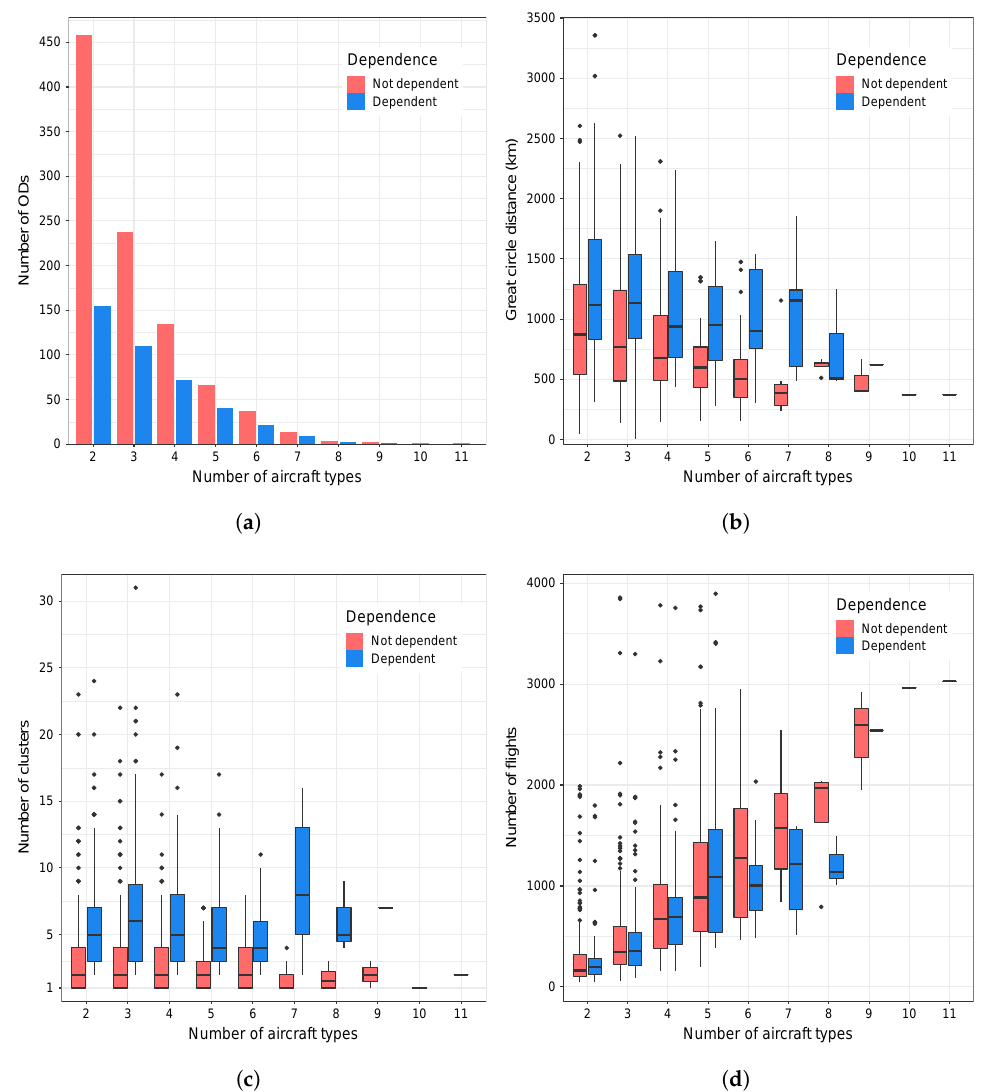
Figure 10. Depiction of the dependence between the aircraft types and trajectory clusters, and their distribution across number of flights and GCD between ODs. ( a ) No. of OD pairs vs. number of aircraft types; ( b ) GCD vs. number of aircraft types; ( c ) number of clusters vs. number of aircraft types; ( d ) number of flights vs. number of aircraft